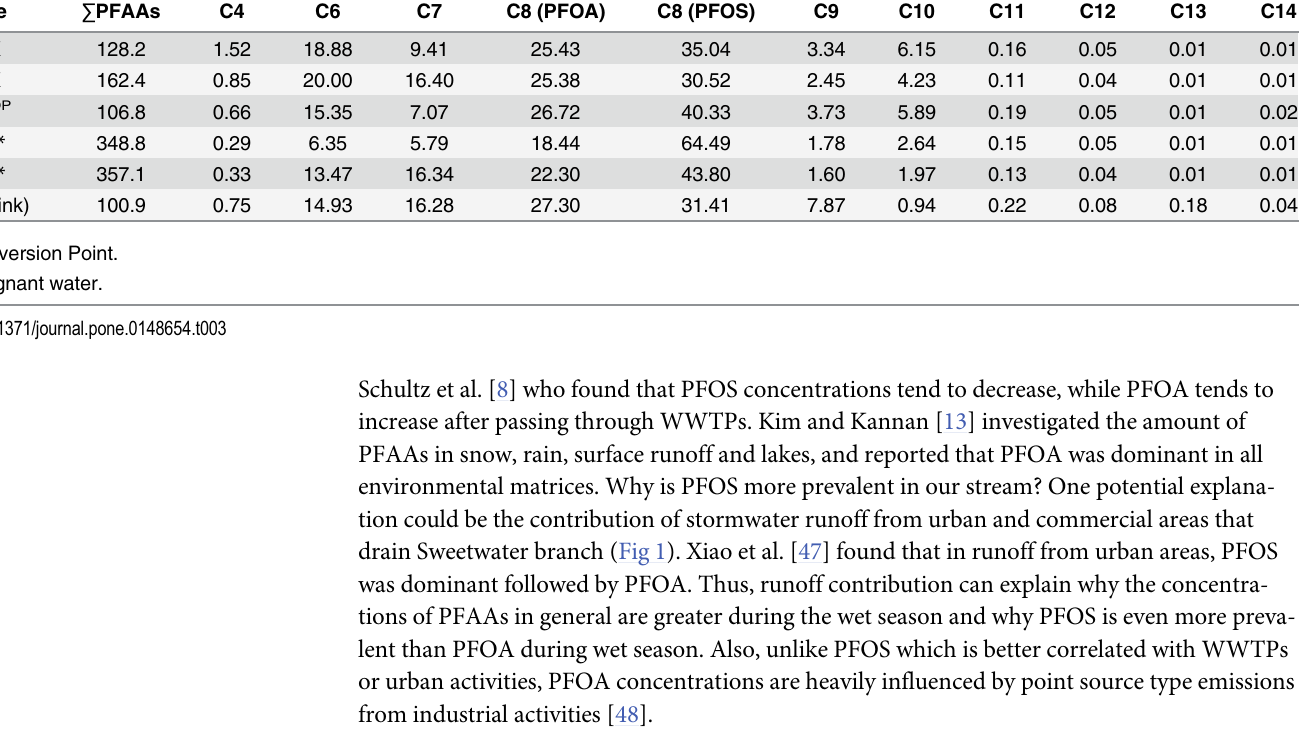
Table 3. Total concentrations (ng/L) and percent of total PFAAs determined in the water column during the dry season at various longitudinal points in Sweetwater branch stream. Site ∑